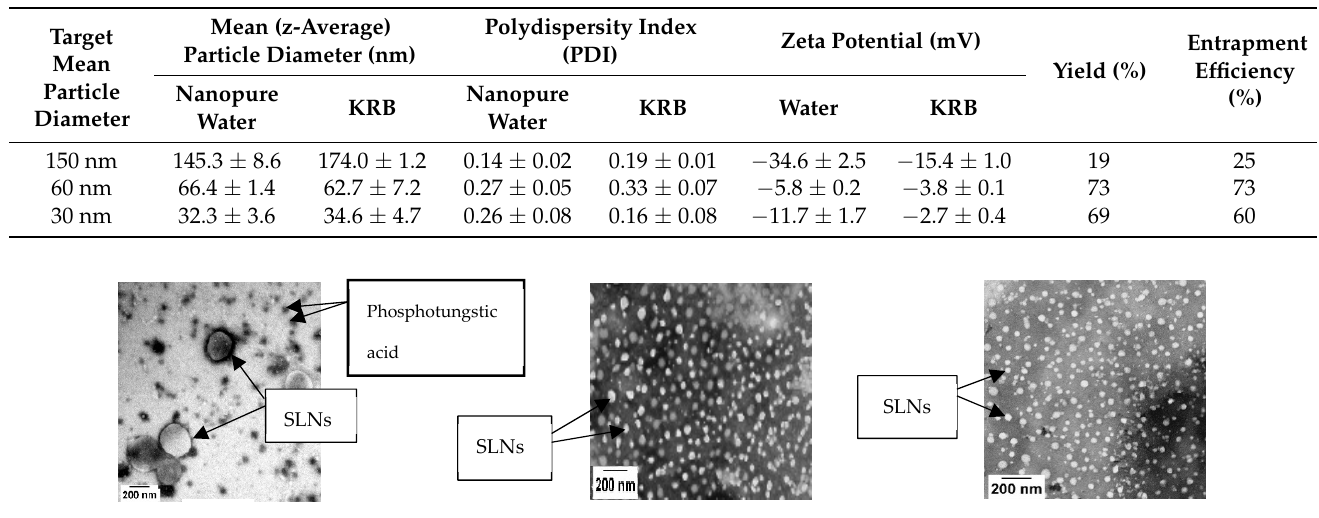
Table 1. Solid lipid nanoparticles size distribution and zeta potential measurements. Data are presented as mean ± standard deviation.